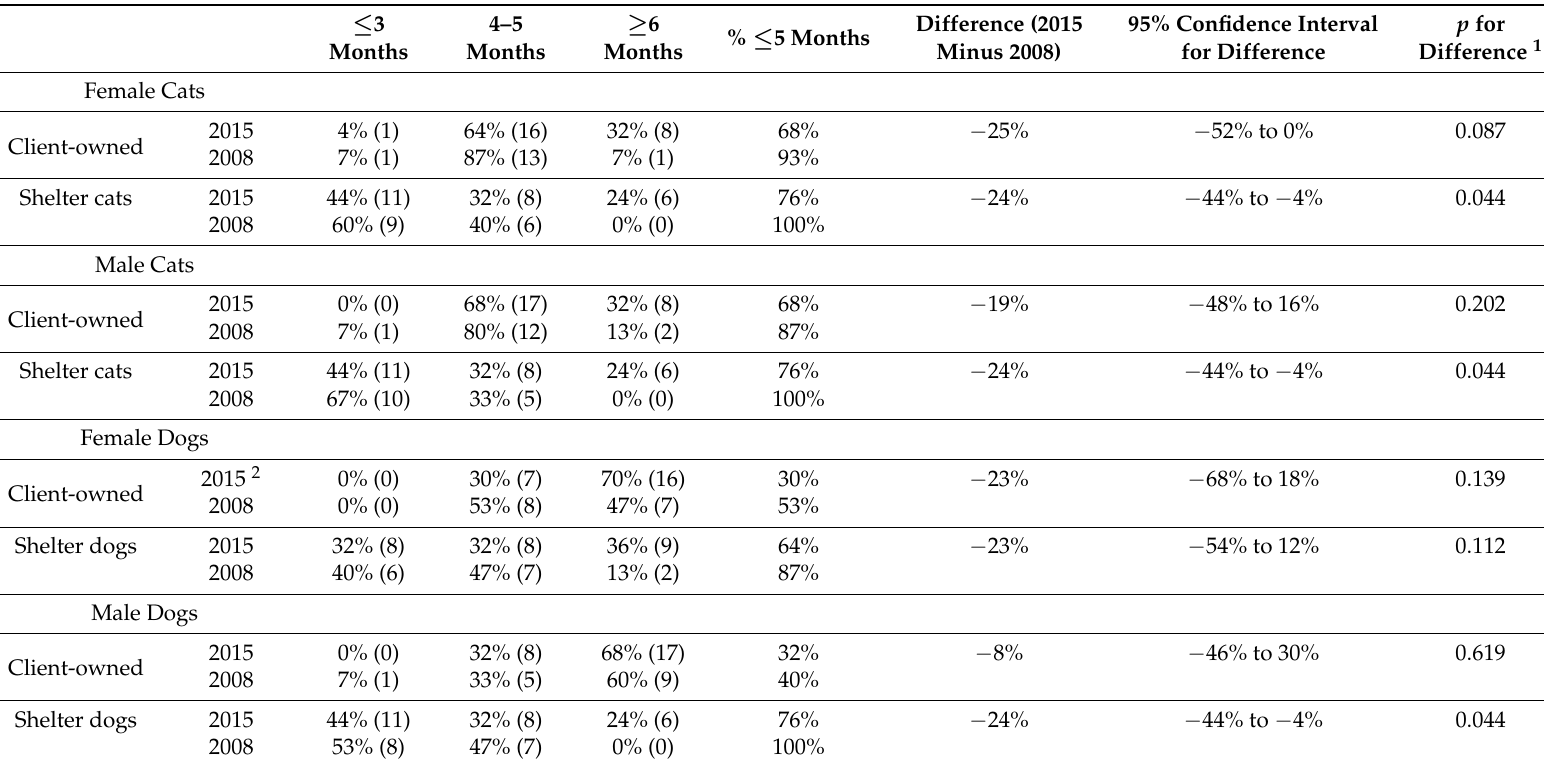
Table 1. Responses (number and percentage) of university veterinary teaching staff from Australia and New Zealand in each of 2008 ( n = 15) and 2015 ( n = 25) to the question ‘For all factors considered, including safety and population control, what age do you think is best to desex each of the following categories ’ Categories were client-owned and shelter female and male cats and